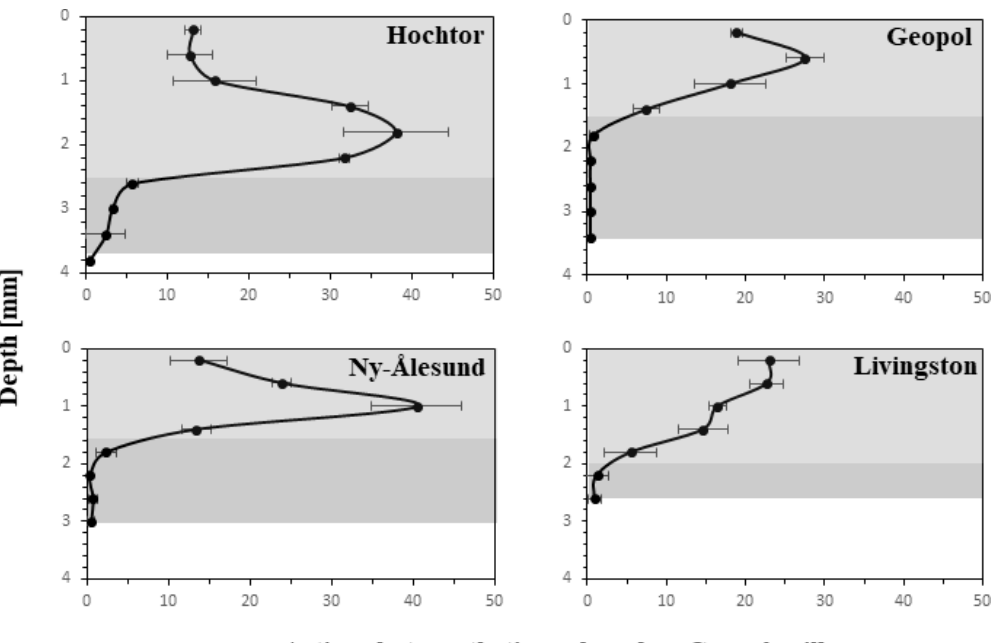
Figure 4. Active photosynthetic carbon (apC) depth profiles. Carbon values calculated from 3-D biomaps with CLSM–IA are plotted against soil depth from surface to where the crust ends with standard deviation. PAL (photosynthetic active layer) is indicated in light grey, describing the soil stratus that contains active photoautotrophic organisms. PIL (photosynthetic inactive layer) is shown in dark grey, marking the soil stratum with inactive photoautotrophic cyanobacteria and green algae. The value representing the deepest point describes the thickness of each